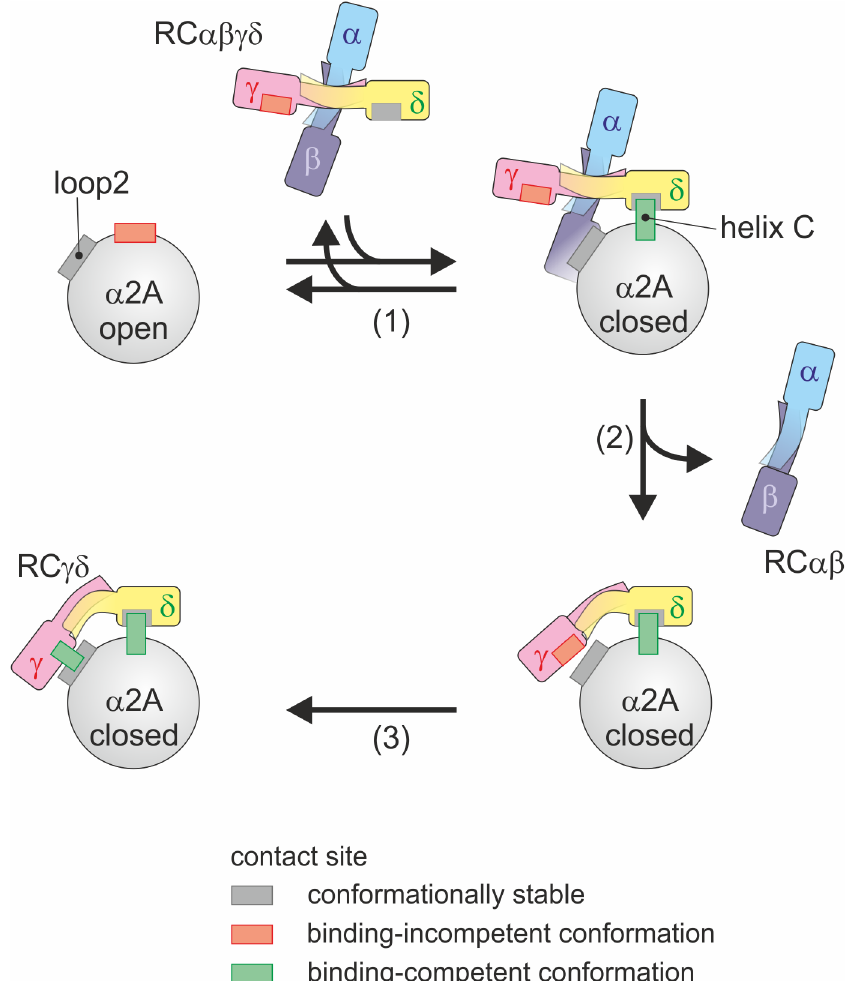
Fig 9. Molecular mechanism of the RC γδ - α 2Ainteraction. As RC αβγδ binds to α 2A in its “closed” conformation, it induces the conformational change of α 2A from its “open” to “closed”conformation and thus shifts the conformational equilibrium(1). This interaction is mediatedvia the conformationally robust RC δ interaction site within helix C, which is only present in the “closed” conformation of α 2A. Subsequently, the index finger loop of RC γ changesits conformation, which is accompanied by a globalmovementof both rhodocetin (RC) core domainstowards each other and by a release of the RC αβ subunit (2). As the RC αβ subunitdiffuses away, this step is likely irreversiblein nature. The globalshapechangeof RC γδ forms a new bay regionthat embraces α 2A and locallyleads to the repositioningof RC γ key residues, which forms another binding-competent interacting site in RC γ for the α 2A loop 2